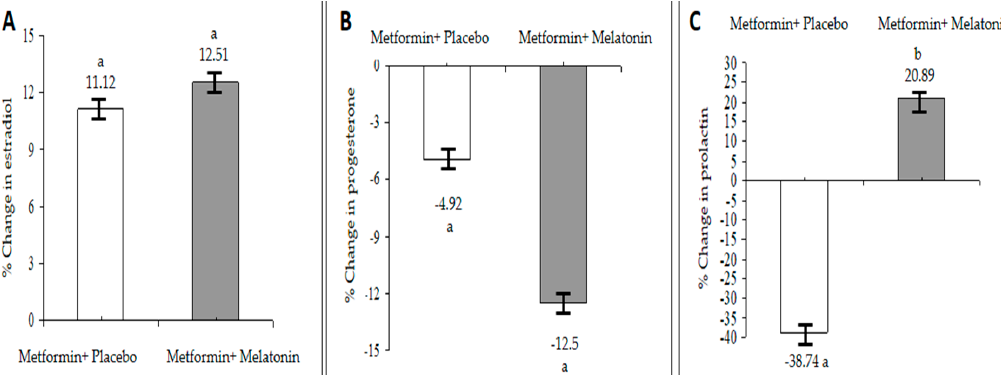
Figure 5. Comparison between the effects of metformin–placebo with metformin-melatonin on serum estradiol( A ), progesterone ( B ) and prolactin ( C ) level in MEBS patients after 90 days of treatment; (a, a) non-significantly different ( p > 0.05), (a, b) significantly different ( p < 0.05).